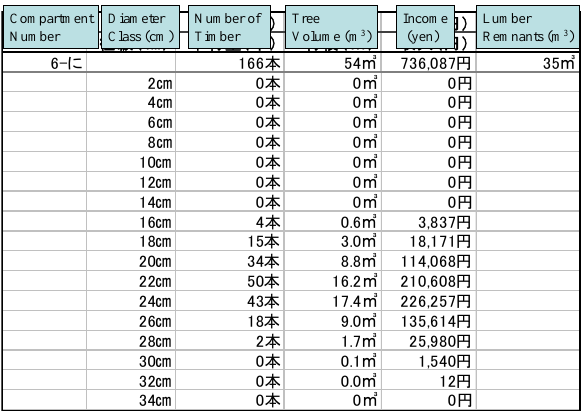
Figure 13. The result indicates that the forest resource